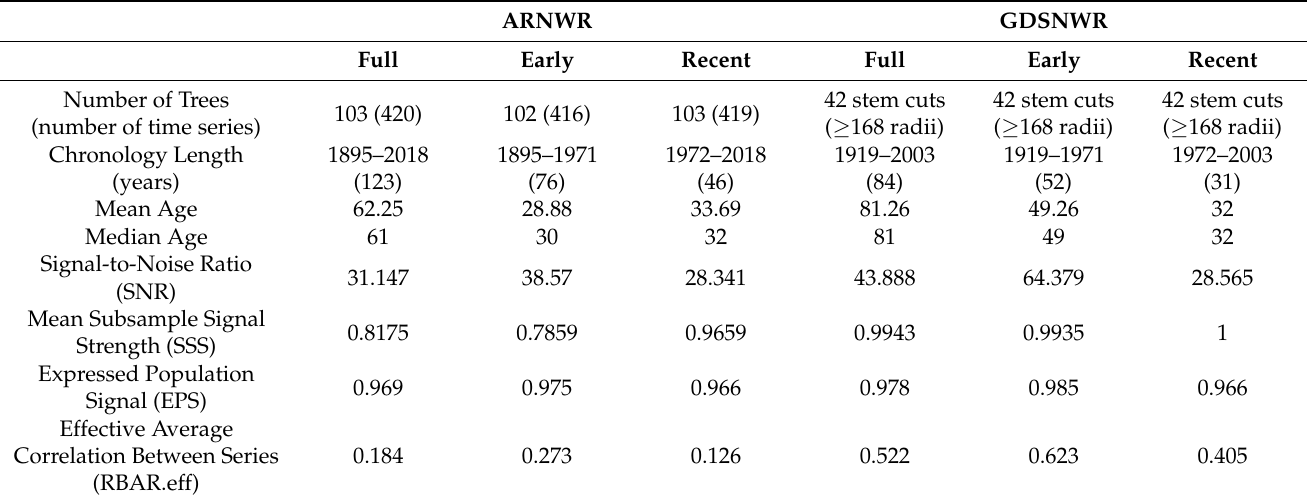
Table 2. Descriptive statistics of ARNWR and GDSNWR chronologies during full, early, and recent